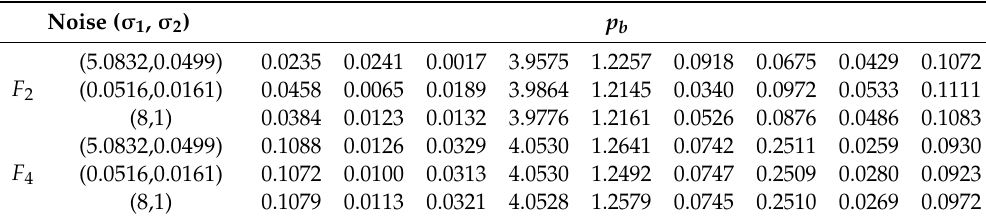
Table 5. Comparison of sensitivity with the noise of F 2 and F